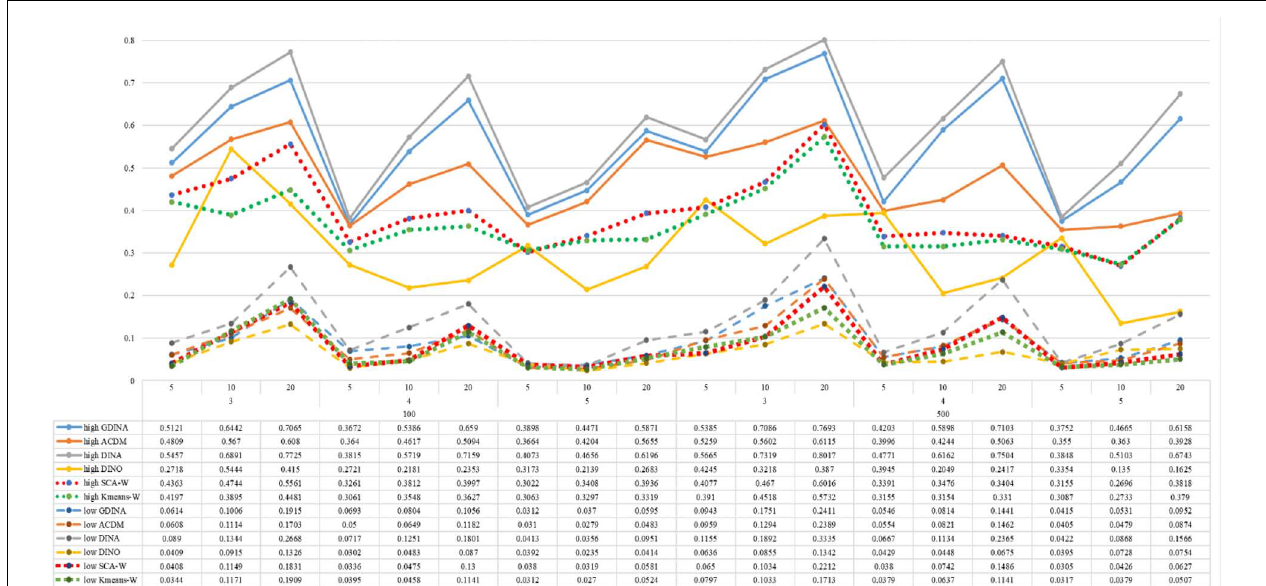
FIGURE 5 | Mean values of ARI by SCA, K-means, and fitted models; True model =